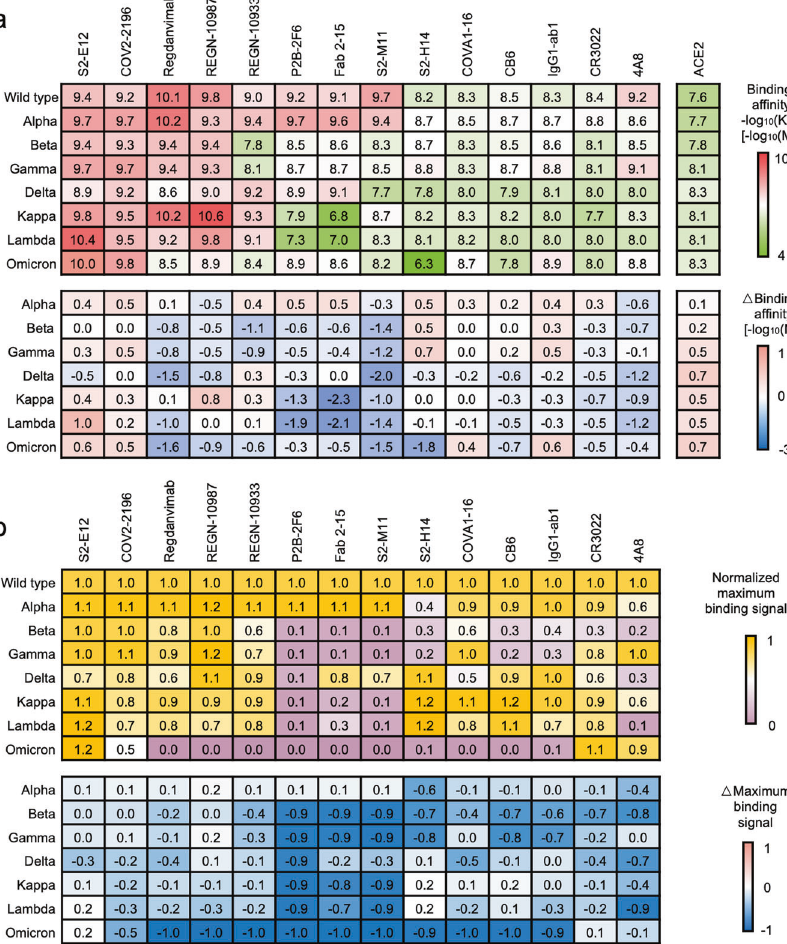
with antibodies or receptor ACE2, we puri fi ed different spike protein variants and neutralized antibodies and performed a complete kinetic analysis to investigate the mutational impact on the binding ability. To provide an experimental reference for in vitro antibody studies, we included two additional RBD-speci fi c antibodies without available co-crystal structures with RBD, called COV2-2196 59 and IgG1-ab1, 60 as well as the NTD-speci fi c antibody 4A8 61 to avoid over-interpretation.